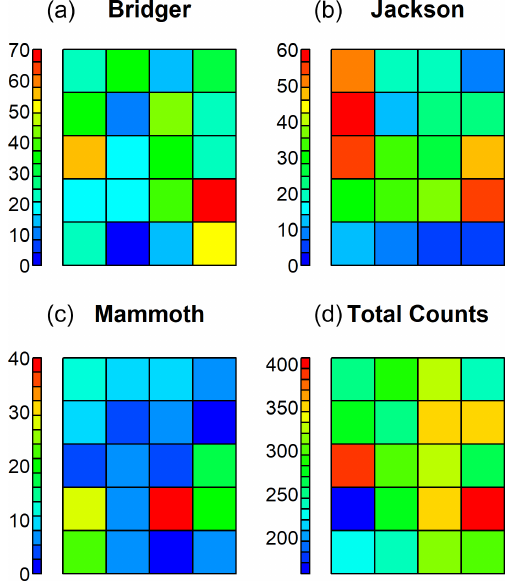
Figure 6. Relative frequencies for each synoptic type within 72h prior to a day with dry deep slab avalanches recorded at Bridger Bowl (a) , Jackson Hole (b) , and Mammoth Mountain (c) , and total counts for the duration of the study period.